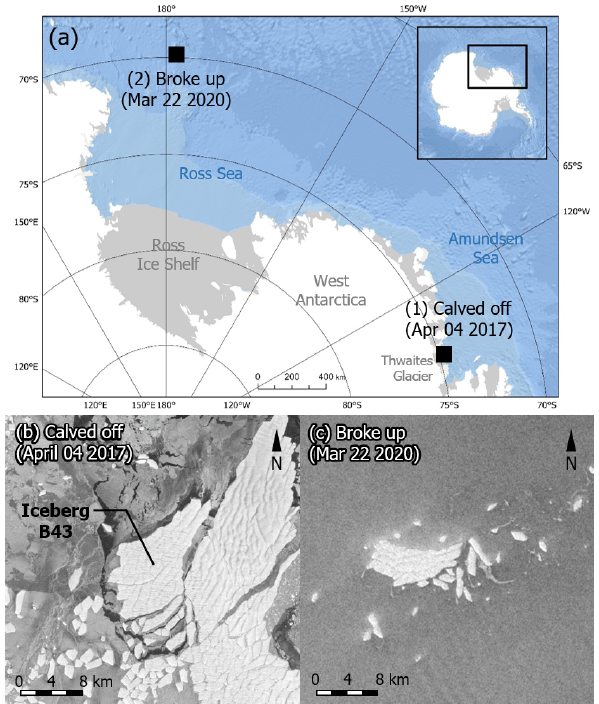
Figure 1. (a) Antarctic region showing the two locations where ice- berg B43 calved off in the Amundsen Sea – (1) 4 April 2017 – and broke up in the Ross Sea – (2) 22 March 2020. (b) Sentinel-1 SAR image showing the ice conditions when B43 calved off at lo- cation (1) and (c) Sentinel-1 SAR image showing the ice and ocean conditions when B43 broke up, with ocean waves around at loca- tion